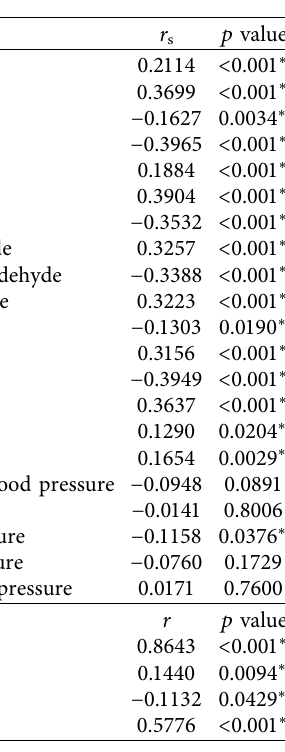
Table 4: Spearman rank correlation and Pearson’s correlation coefficient studies of the biochemical parameters studied in hy- pertensive